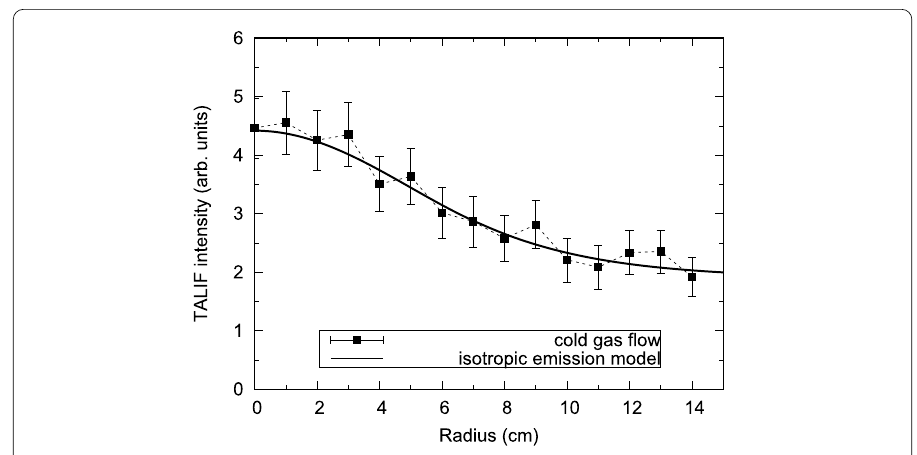
Figure 8 Radial profile of the krypton density at the axial distance of 8 cm. Adopted from Eichhorn et al. Paper IEPC-2019-503 [79]